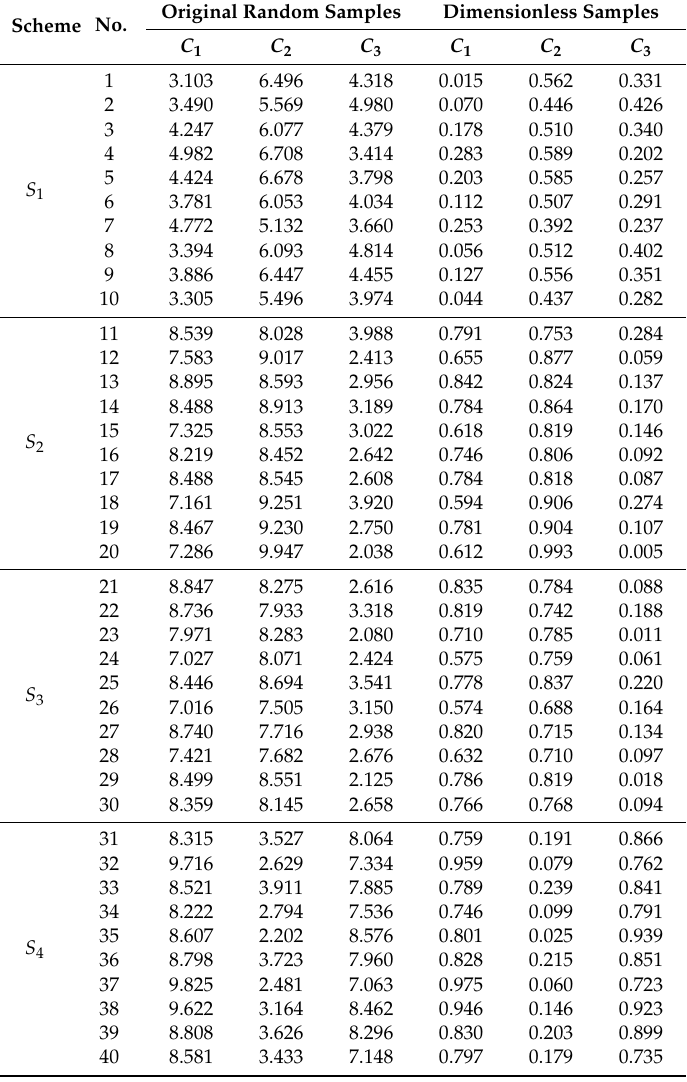
Table 3. Random samples of each water pollution ecological compensation scheme. Scheme